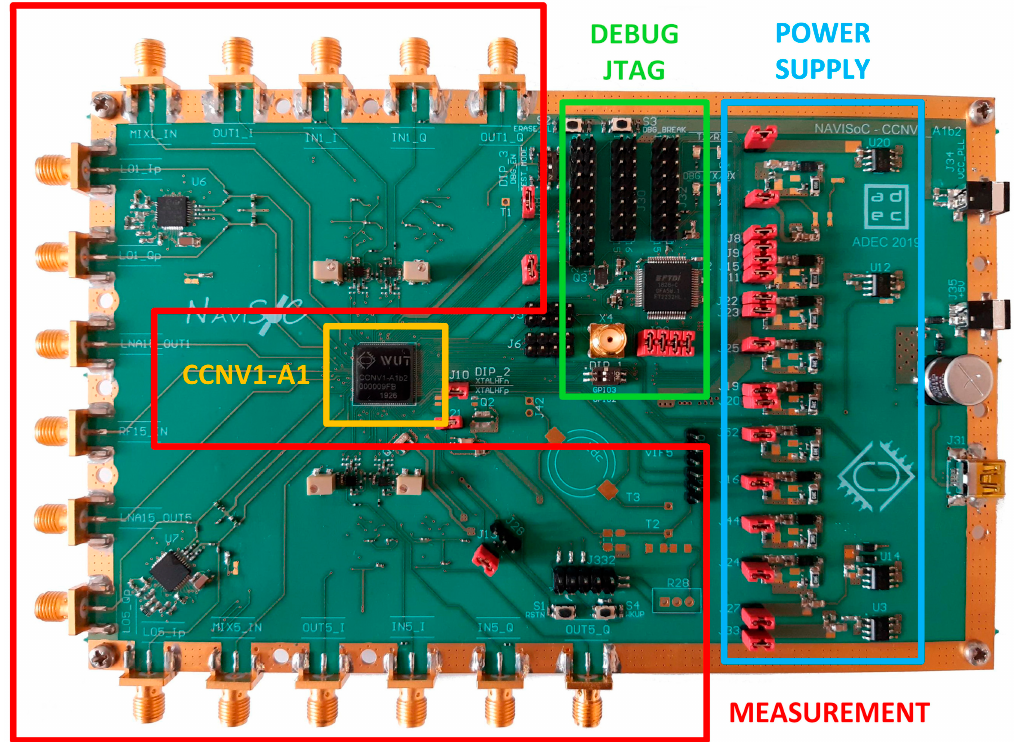
Figure 15. CCNV1-A1 measurement and evaluation board. The PCB (printed circuit board) board contains an CCNV1-A1 integrated circuit (IC) with surrounding radio frequency (RF) test and measurement infrastructure. The power supply is composed of a separate linear regulator for each analog and digital IC part for test purposes.